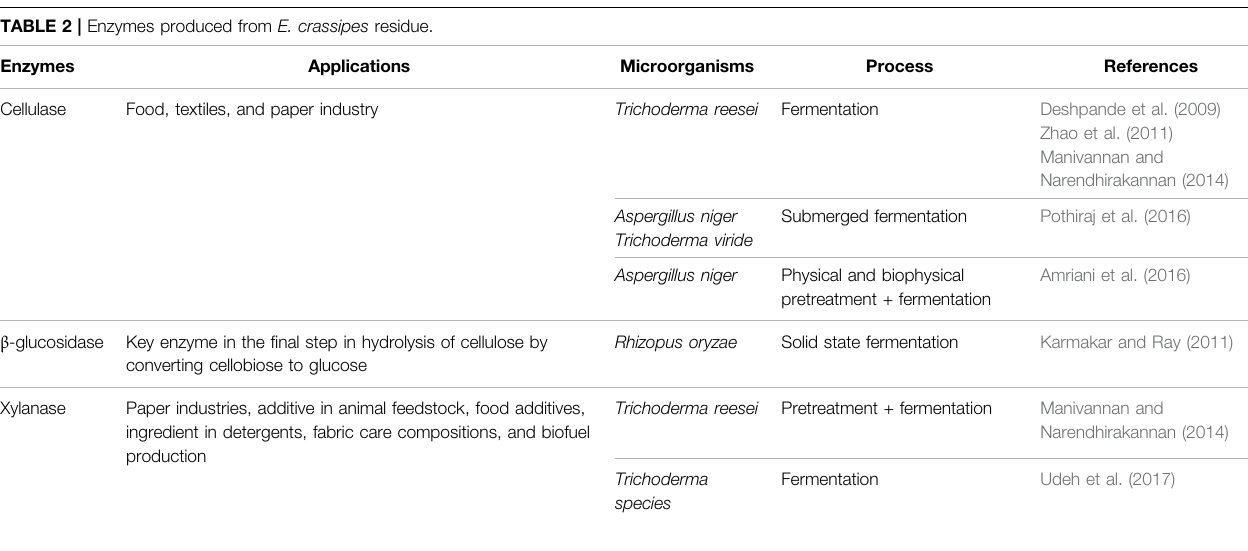
TABLE 2 | Enzymes produced from E. crassipes